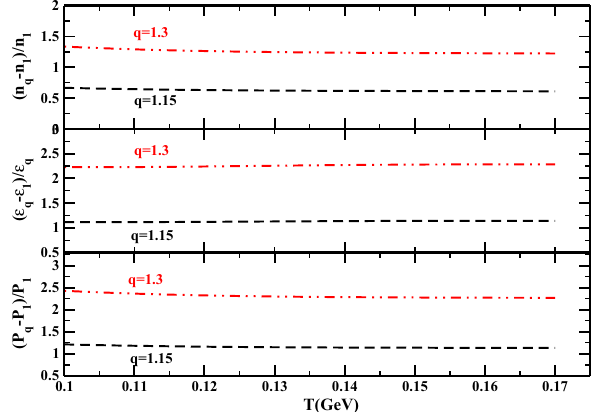
Fig. 1 Relative ratios of the non-extensive correction to the q = 1 values of the thermodynamic quantities